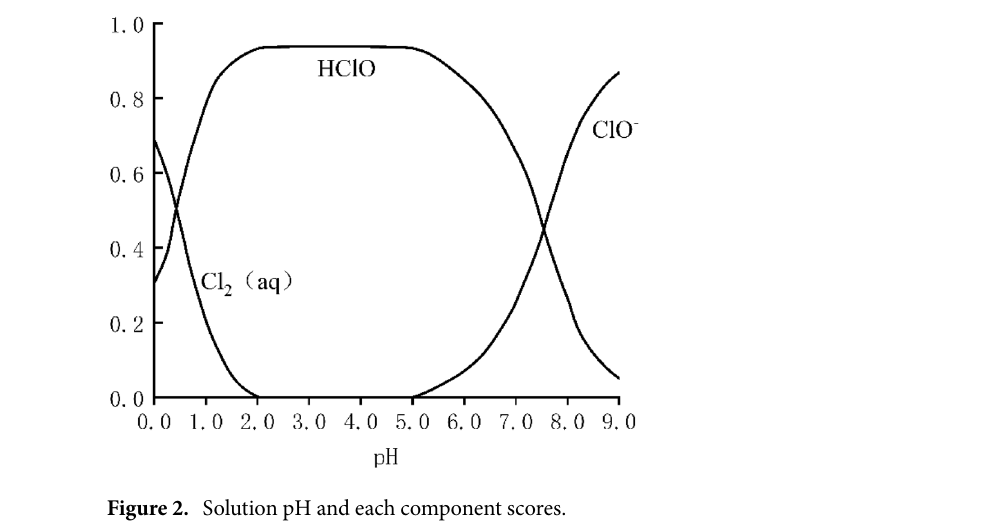
Figure 2. Solution pH and each component